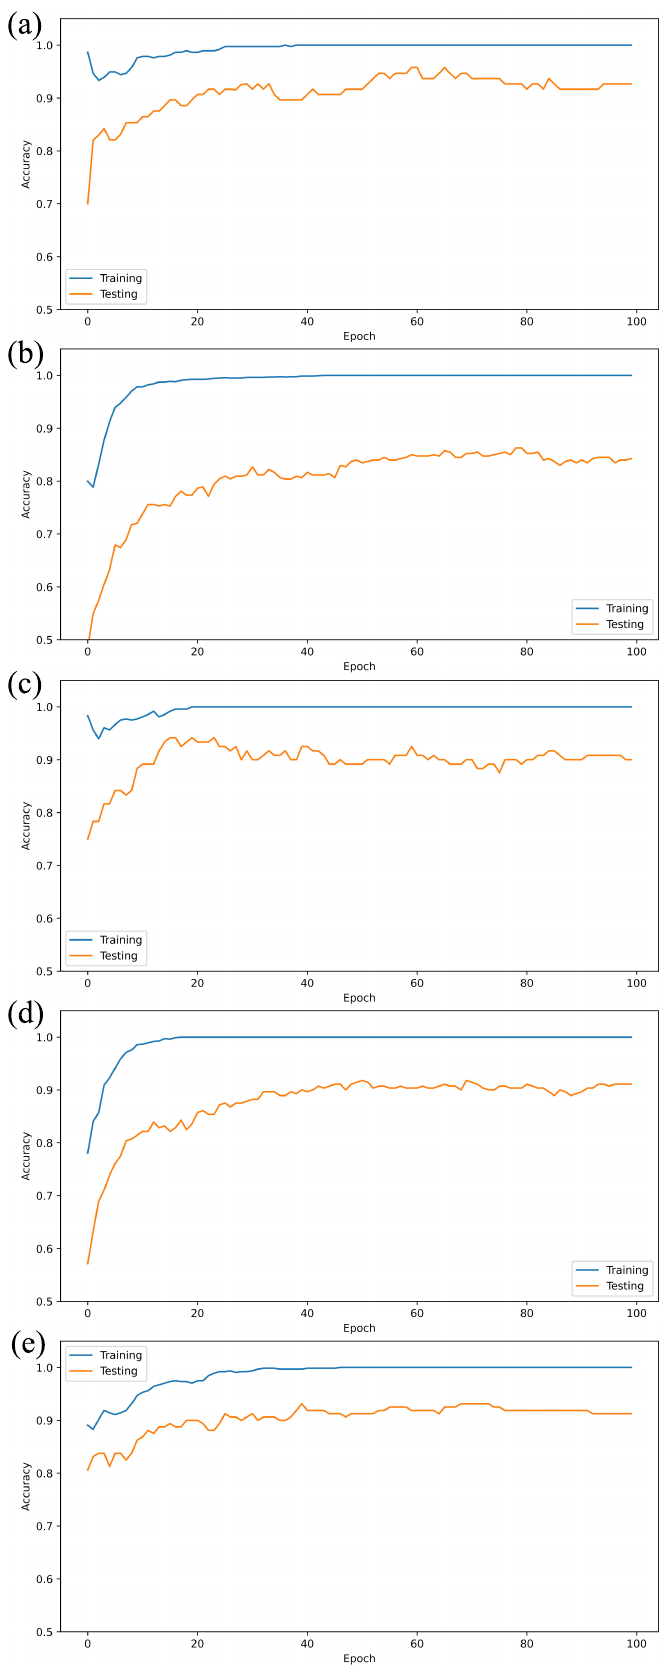
Figure A3. Learning Curve: Training and testing accuracy for P1 ( a ), P2 ( b ), P3 ( c ), A1 ( d ) and A2 ( e